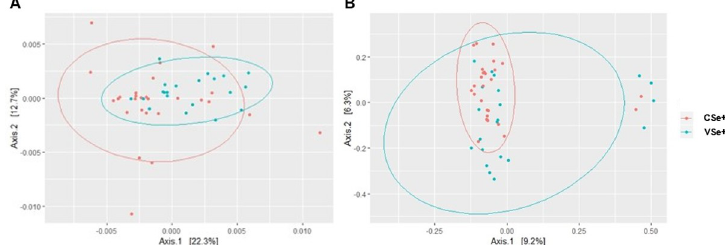
Fig 1. Principal coordinate analysis (PCoA) of the overall microbiota composition of exclusively breastfed infants from secretor mothers by birth mode using (A) unweighted and (B) weighted UniFrac distances. VSe+: vaginal, secretor; CSe+: cesarean, secretor.